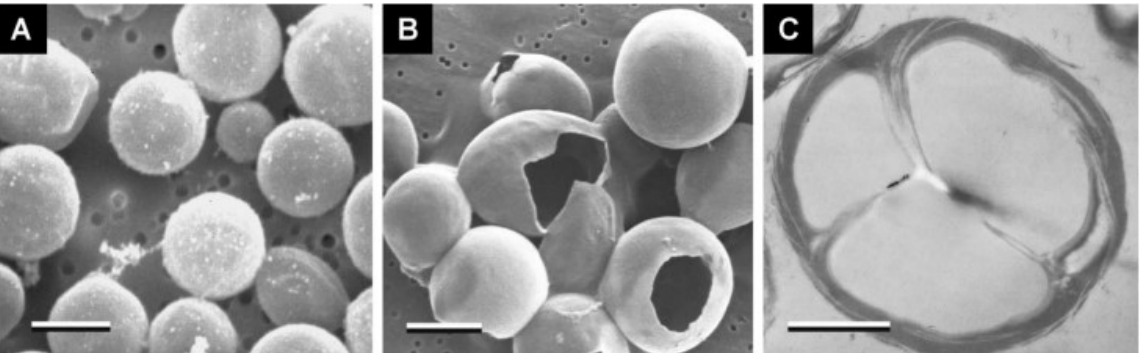
Figure 1. Microscopic image of elastic rubber particles. ( A ) Conventional SEM. ( B ) Field